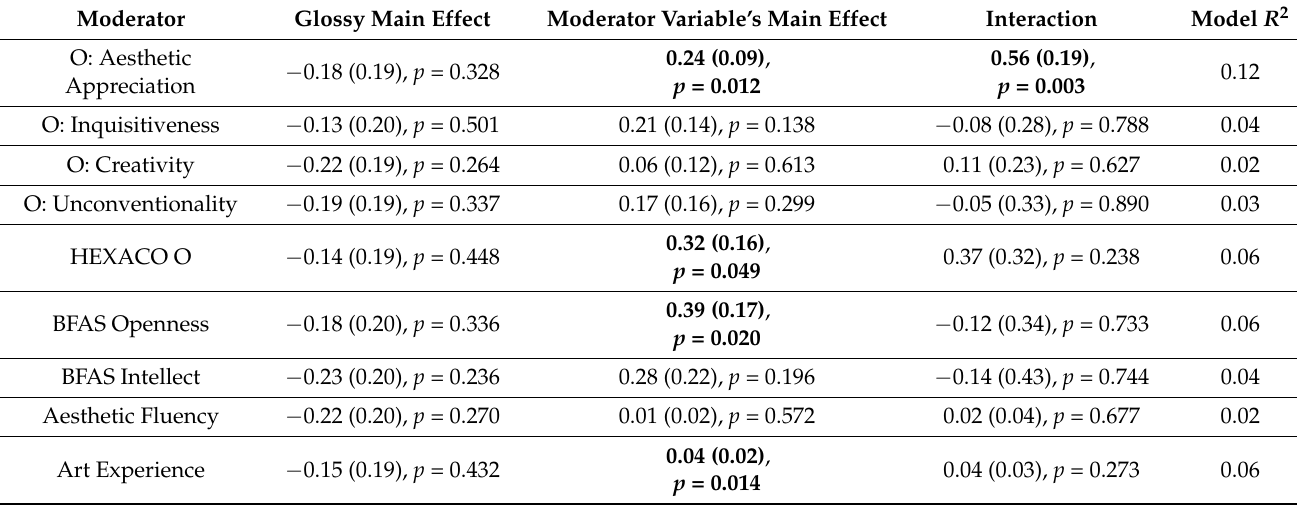
Figure 2. Interaction of paper glossiness and the HEXACO Aesthetic Appreciation facet on attrac- tiveness ratings. (Note. The bands around the regression lines are 95% confidence intervals.). Table 2. Interactive effects of glossiness and individual differences on